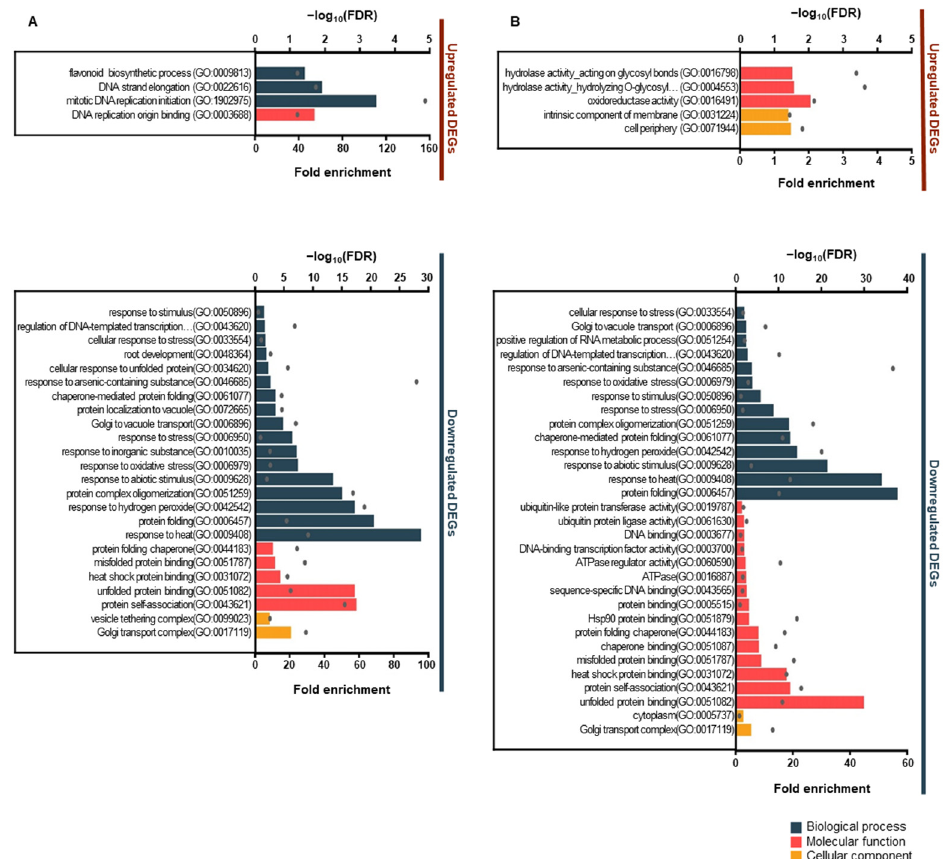
Figure 3. Gene Ontology (GO) enrichment analysis of differentially expressed genes (DEGs). Enriched GO terms of upregulated and downregulated DEGs between red pericarp (RP) and white pericarp (WP) rice at 14 days after flowering (DAF) ( A ) and 28 DAF ( B ). Bar charts represent the –log 10 false discovery rate (FDR) of enriched GO terms with an FDR of <0.05, and the gray dots denote fold enrichment. Table 1. Kyoto Encyclopedia of Genes and Genome pathway enrichment analysis of differentially expressed genes between red and white pericarp rice.